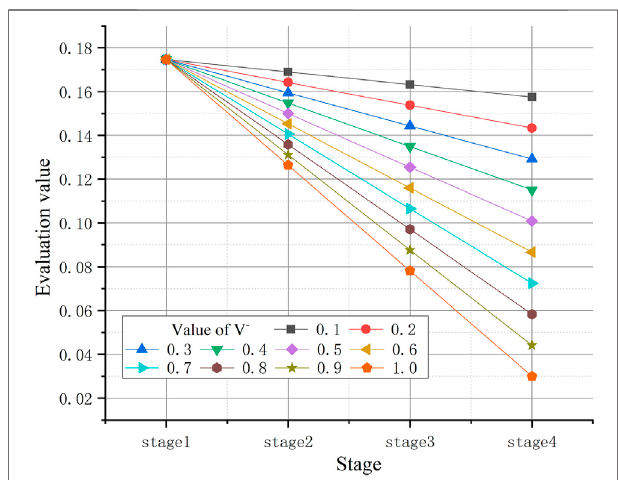
FIGURE 9 | In fl uence of different V − on negative excitation line.